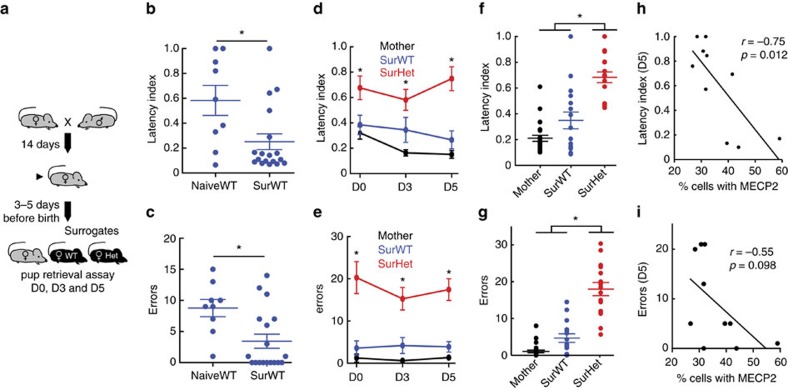
Female Mecp2het mice perform poorly at pup retrieval behaviour.(a) Schematic of behavioural paradigm. Virgin Mecp2het (Het) and wild type littermates (WT) mice were co-housed with a pregnant female before birth of pups. Surrogates (Sur) were tested on the pup retrieval task on days 0 (D0), 3 and 5 after birth. (b,c) SurWT tested on D5 (N=18 mice) showed significant improvements on a normalized measure of latency to gather (b) and reduced number of gathering errors (c) compared with pup-naive mice (N=9 mice) (Mann–Whitney, *P=0.027). Lines represent mean±s.e.m. (d,e) Mean performance at D0, D3 and D5 for mothers, SurWT and SurHet as measured by normalized latency (d) and errors (e).Lines represent mean±s.e.m. SurHet showed consistently poorer pup retrieval performance than mothers and SurWT in all three sessions (N=13–24 mice; Kruskal–Wallis with Bonferroni correction: H values for latency — D0=9.4, D3=13.05, D5=21.68; H values for error—D0=26.07, D3=26.31, D5=24.32; *P<0.05). (f,g) Mean performance of normalized latency (f) and errors (g) averaged over all three sessions (N=13–24 mice; Kruskal-Wallis with Bonferroni correction: latency—H=29.95, error—H=35.45; *post-hoc P<0.05). SurHet had significantly longer latency and made more errors compared with mothers and SurWT. Mean±s.e.m. are shown in line. (h,i) At D5 Sur, Het performance of normalized latency (h) and errors (i) negatively correlated with percentage of cell population expressing MECP2 (N=10 mice; Pearson's r: For H: r=−0.75, P=0.0012; for I: r=−0.55, P=0.098).